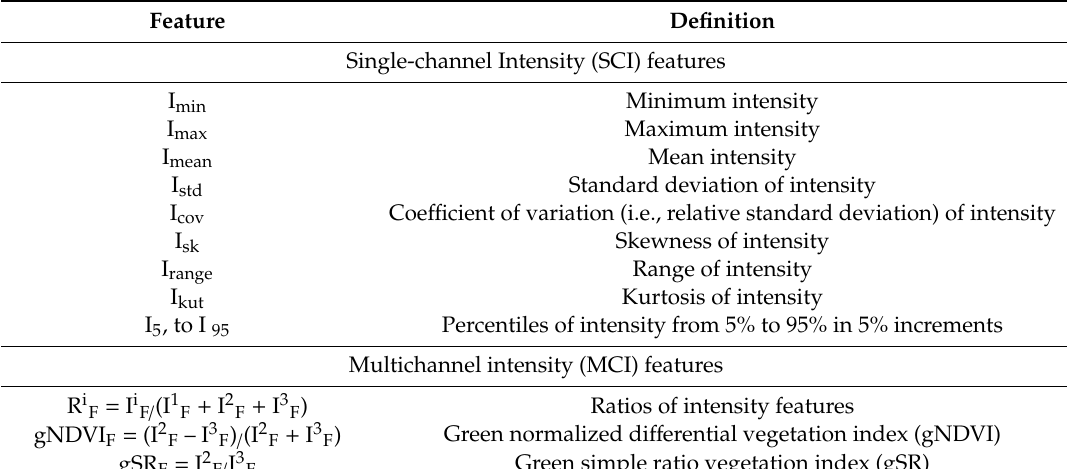
Figure 3. A simplified schematic illustrating canopy thresholds (C th s). Table 4. List of all features derived from spectral information of the laser returns Superscripts (i) 1, 2, and 3 represent channel numbers and subscript F refers to single-channel intensity feature